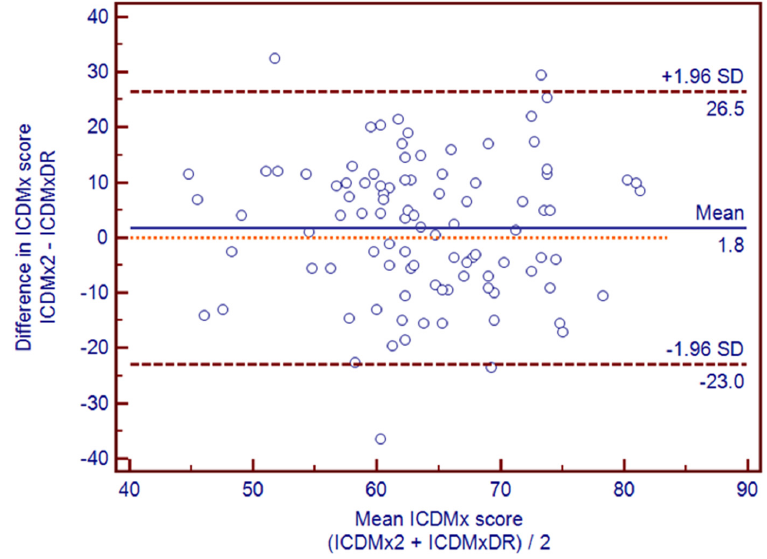
Figure 2. Bland ‐ Altman plots illustrating the relationship between ICDMx score estimated from FFQ2 and the average ICDMx from nine ‐ day DR ( n =